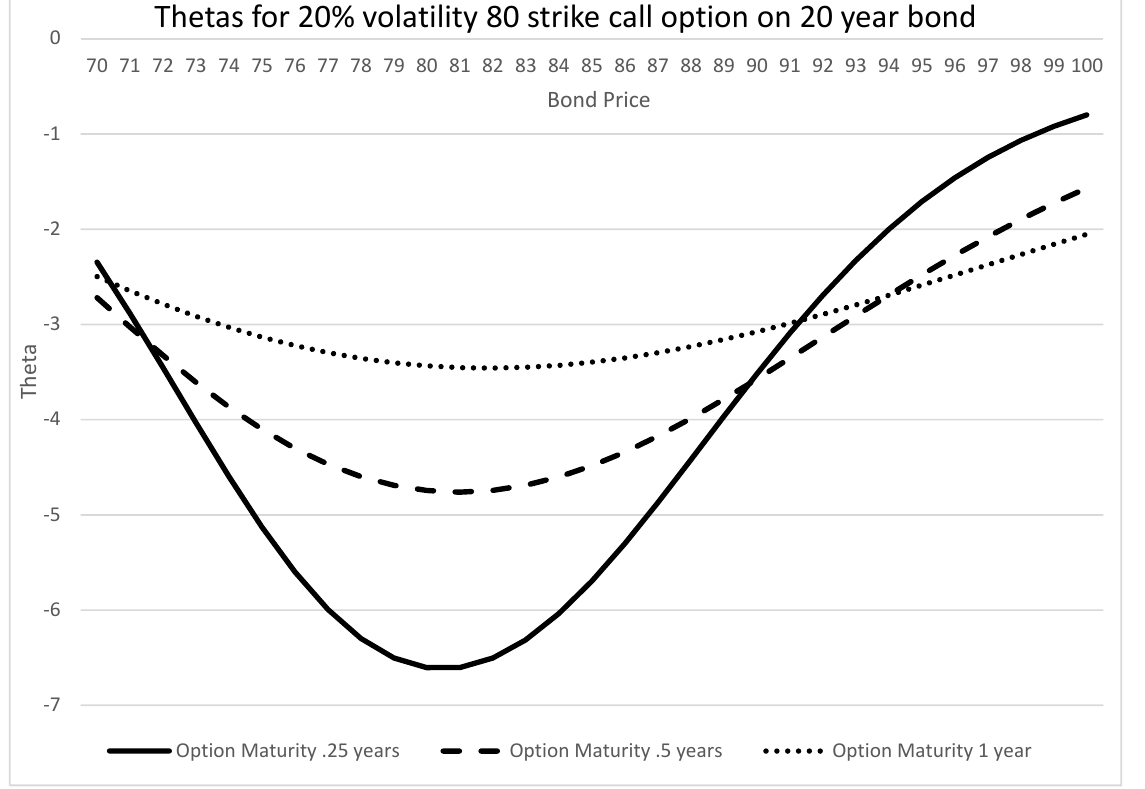
Figure 5. PTP thetas at different option maturities.